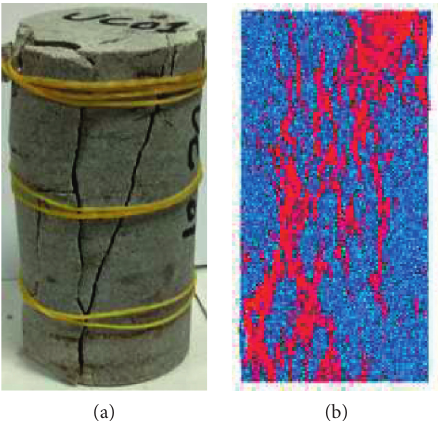
Figure 3: Failure modes of sandstone based on experimental and numerical tests: (a) experimental test; (b) numerical